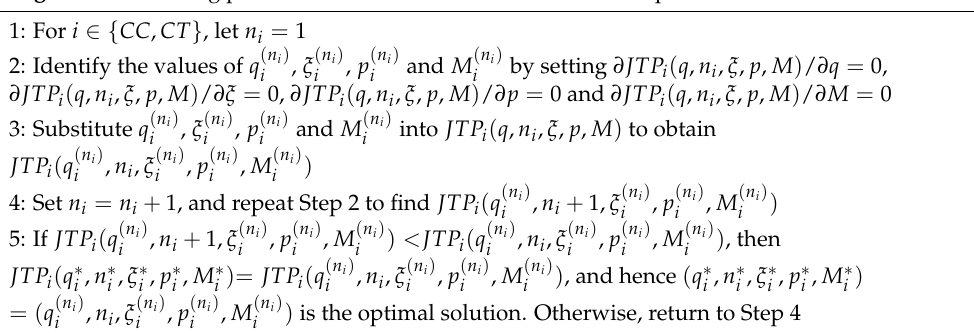
Algorithm 1 . Solving procedures under various carbon emission